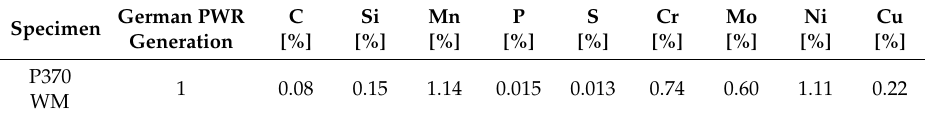
Table 1. Chemical composition of CARINA / CARISMA studied steels in wt. % (Fe balance) [33,34].